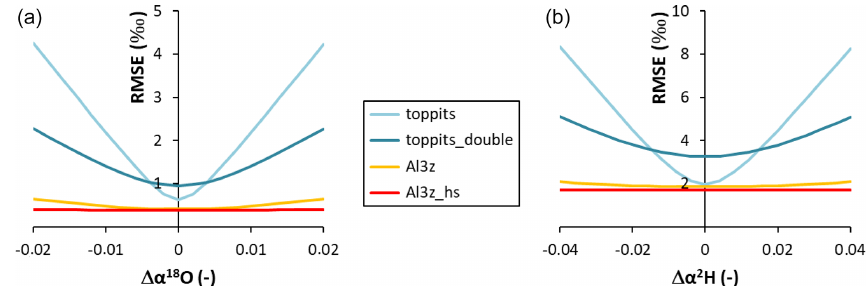
Figure 6. Absolute model RMSE values as functions of the absolute deviations ( (cid:49) ) from the RMSE-optimized values of α 18 O (a) and α 2 H (b)